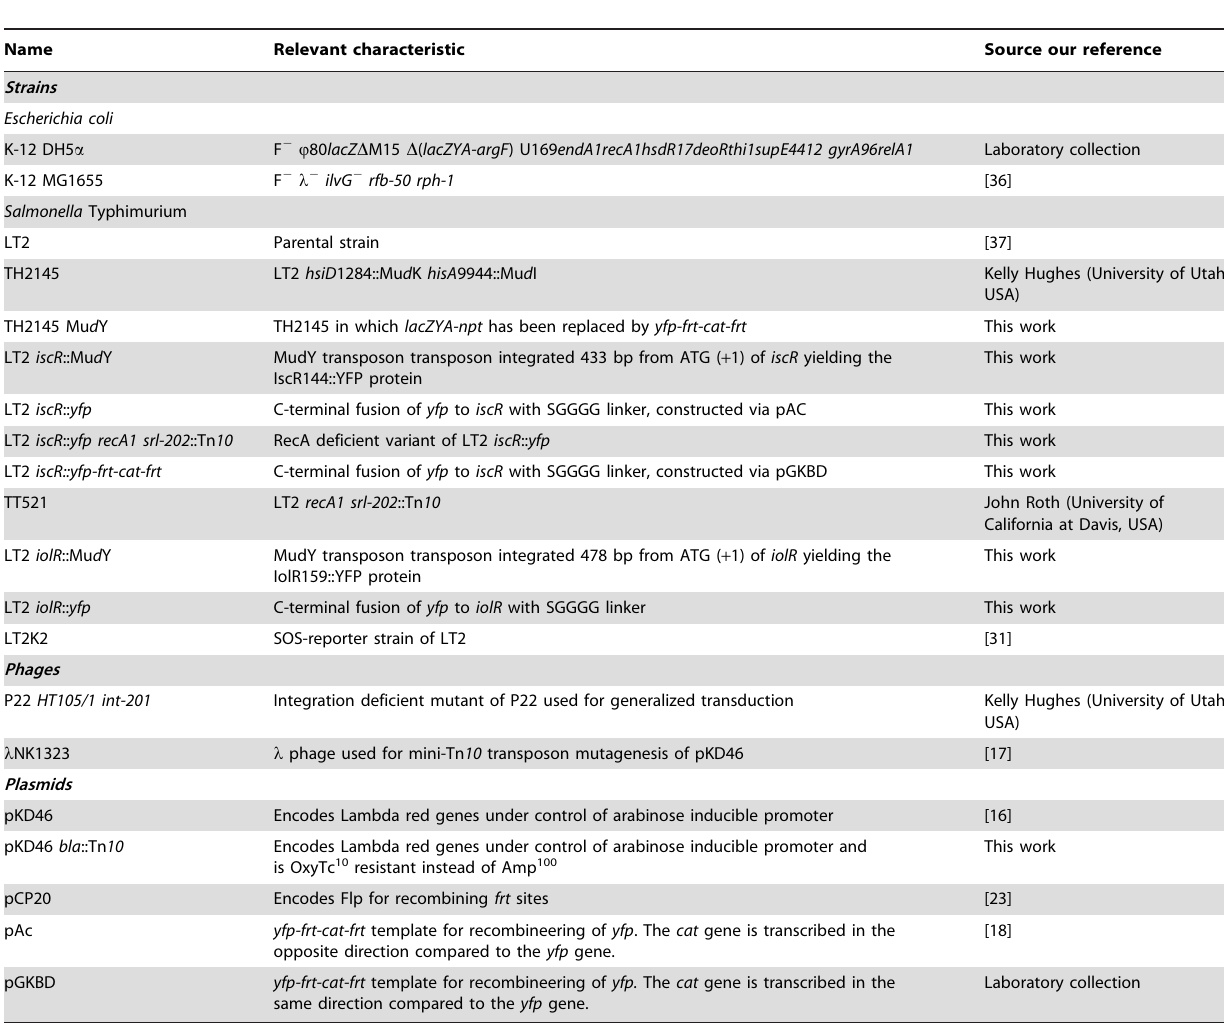
Table 1. Strains, phages and plasmids used in this